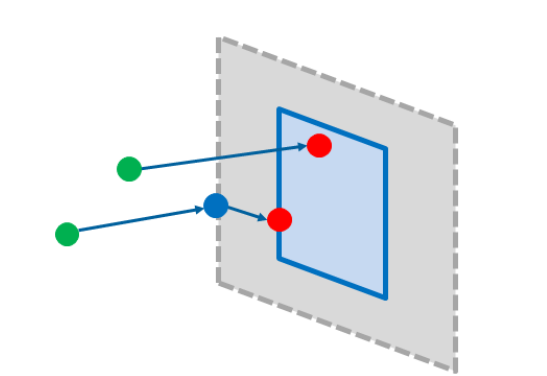
Figure 3. Finding matching points using point-to-plane ICP. Source points (green) from a point cloud are associated to match- ing points (red) on the facade plane with minimal distance. Matching points are contained in the facade polygon (light